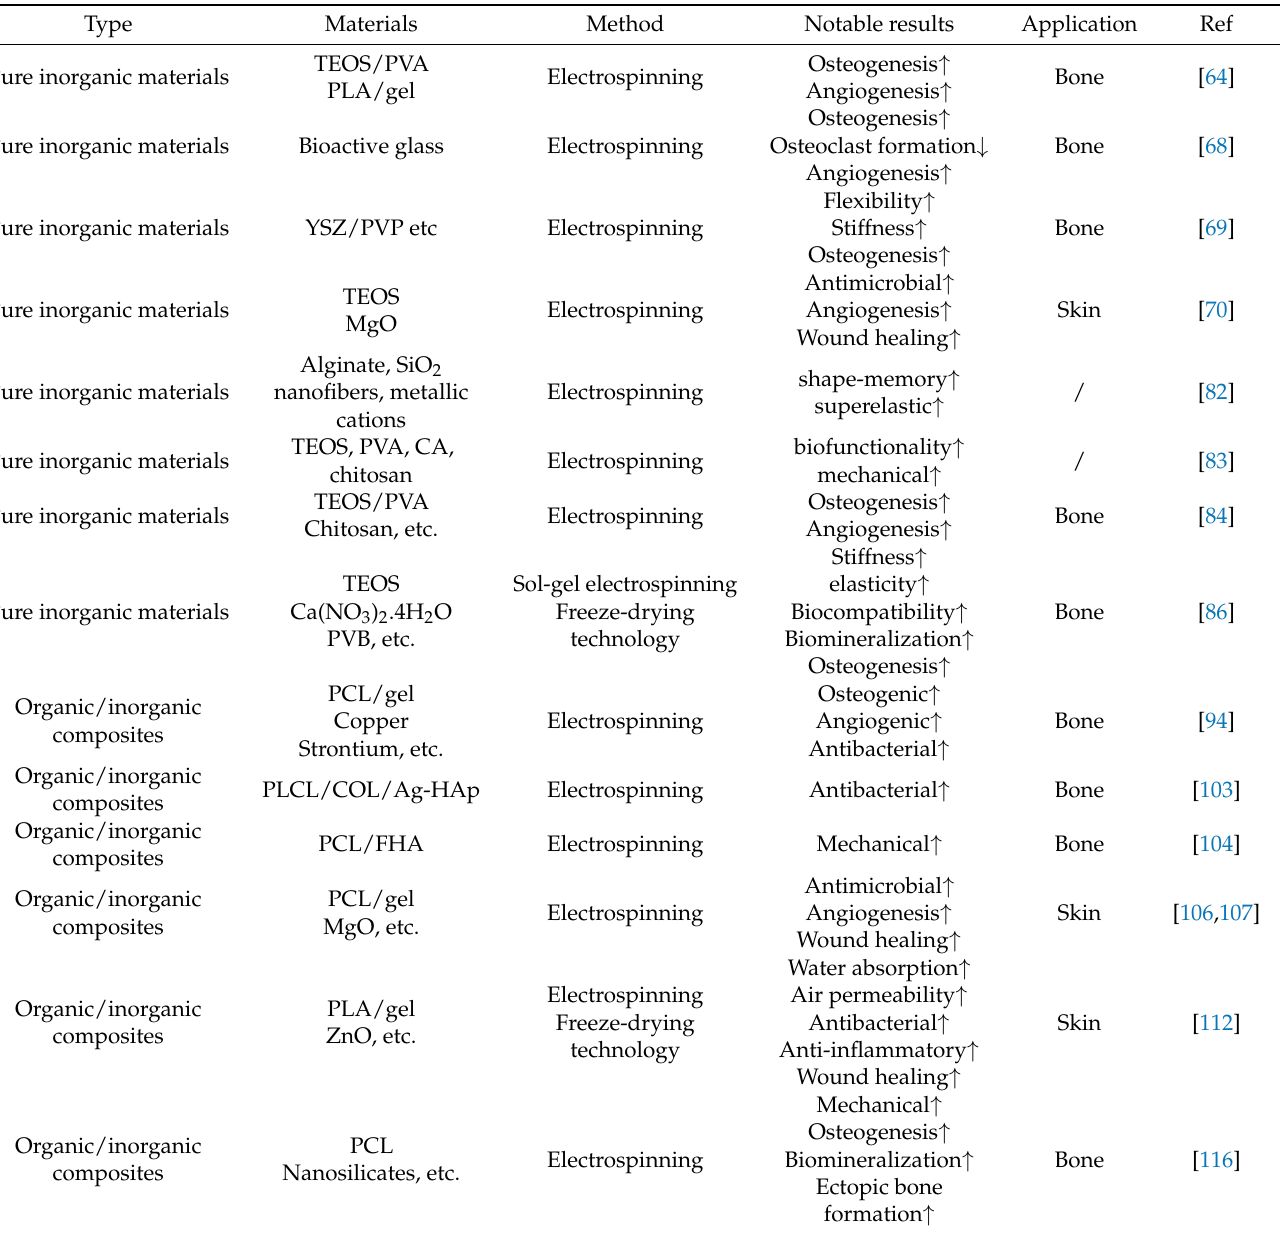
Table 1. Summarized results of composite nanofibers containing different types of inorganic